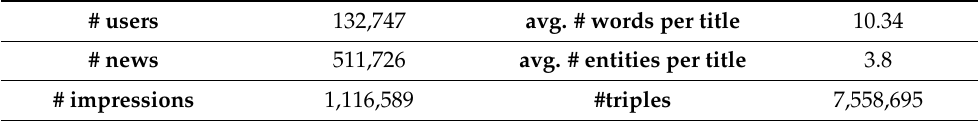
Table 1. Dataset